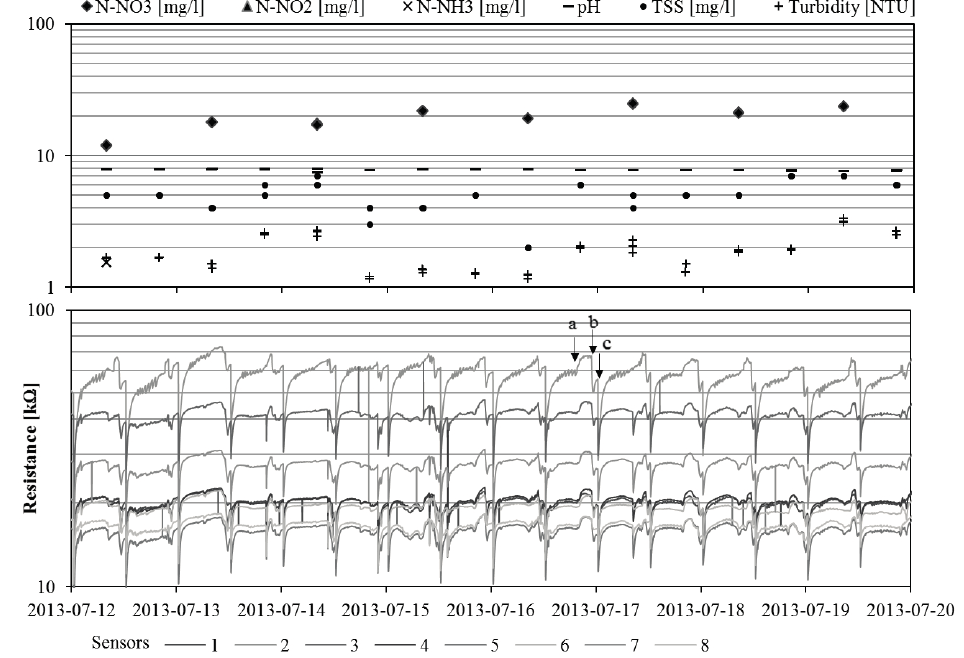
Figure 3. Results of one-week measurements from both the standard measurement ( upper chart ) and gas sensor array ( lower plot ), a—start of sedimentation, b—raw sewage load, c—beginning of